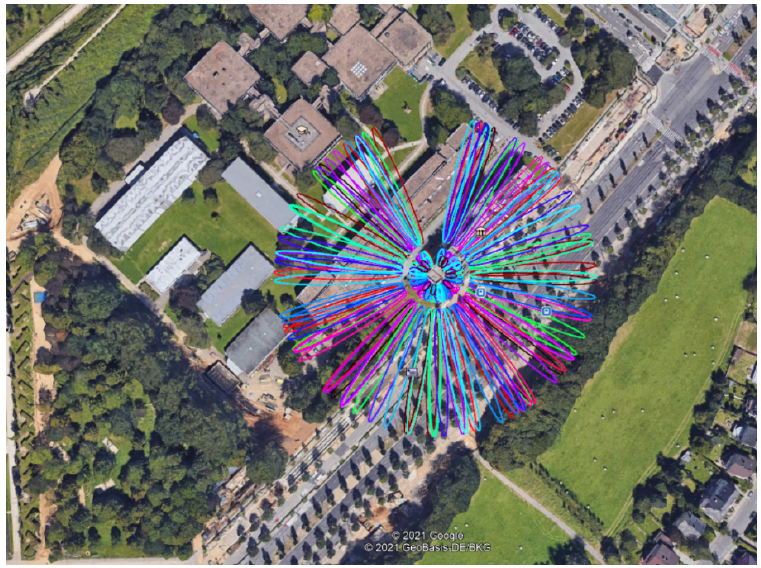
Figure 2. The Screenshot of the first Fresnel Zone at KBG1/KBG2 on the roof of the JFK building, Kirchberg campus, Luxembourg city, using elevation angles of 5, 10, 15, and 30 degrees. The coloured ellipses represent all GPS satellites visible at KBG1/KBG2 location. An antenna height of 3.5 metre is used. Credit of background image: Google